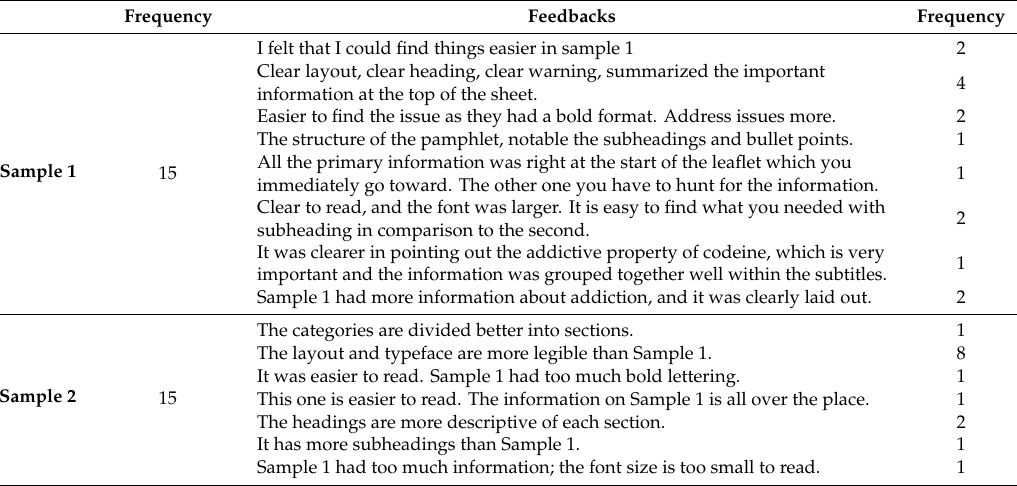
Figure 8. The results of two questions from a follow-up survey. From the left to the right: ( a ) In what situation do you tend to buy codeine-containing medicines? ( b ) How do you think of the availability and regulation of codeine? ( c ) Have you seen these two patient information leaflets before? For participants’ preference of sample PILs summarized in Table 4, Sample 1 and 2 were both favored by 50% of readers. However, the feedback from the participants indicated that Sample 2 was mostly favored for its overall layout, while Sample 1 was preferred for its clear heading, summarization of information in the headline section, and clear and repeated warning on addiction. Table 4. Answers to the question “Which PIL is more helpful to you?”.